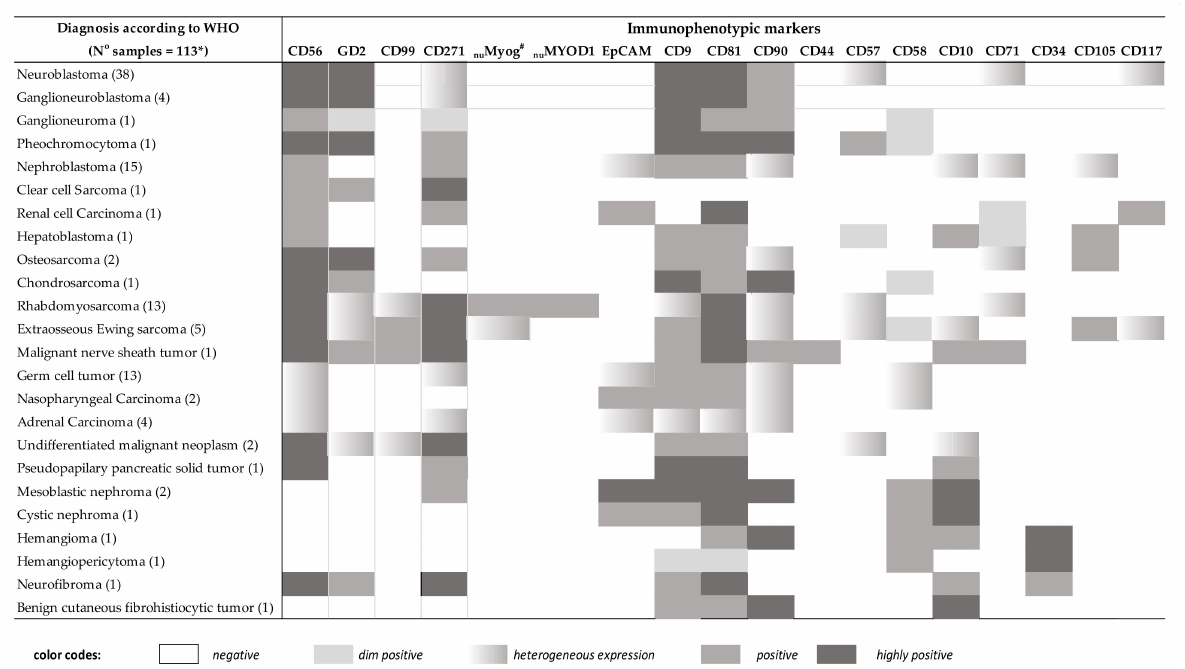
Figure 3. Pattern of expression of individual immunophenotypic markers in distinct WHO/ICCC-3 diagnostic categories of pediatric solid tumors. Heat map summarizing the intensity and pattern of expression of different phenotypic markers for the different diagnostic subtypes of pediatric solid tumors based on both the mean fluorescent intensity level of expression per/cell and the percentage of positive cases. * 5 samples were not diagnosed by MFC (1 hepatoblastoma, 1 osteosarcoma, 1 extraosseous Ewing sarcoma, 1 nasopharyngeal carcinoma, 1 hemangioma). # In one patient with an Ewing sarcoma, nu myogenin expression was positive both on MFC and